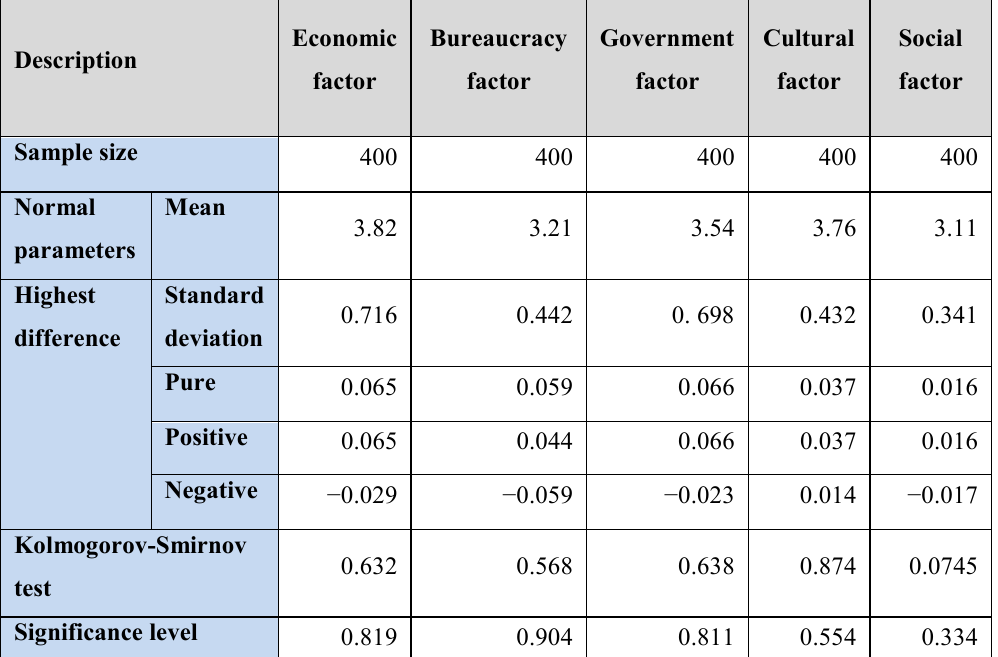
Table 1. The Kolmogorov-Smirnov Test for the Study of the Economic Factor, Bureaucracy, Governmental, Cultural and Social Factors in